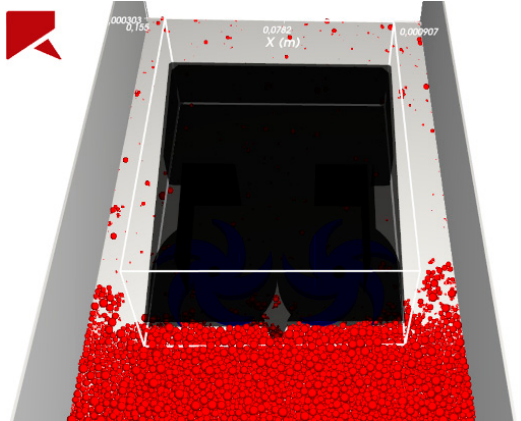
Figure 3. Starting conditions—front view.